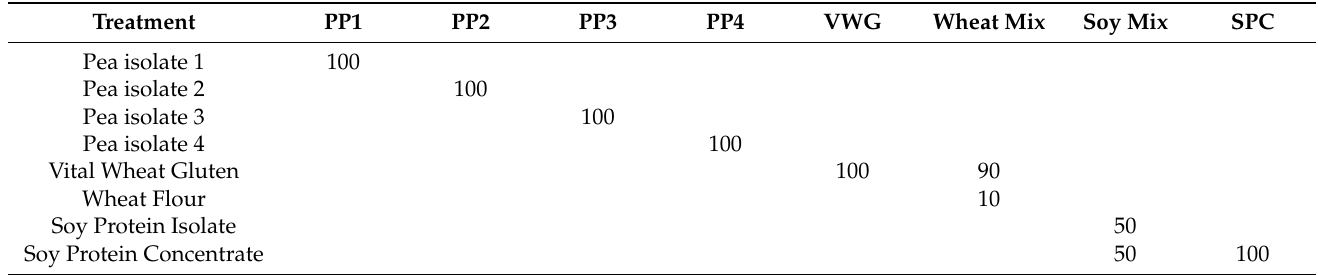
Table 1. Formulas (%) used in the extrusion treatments for plant-based meat.